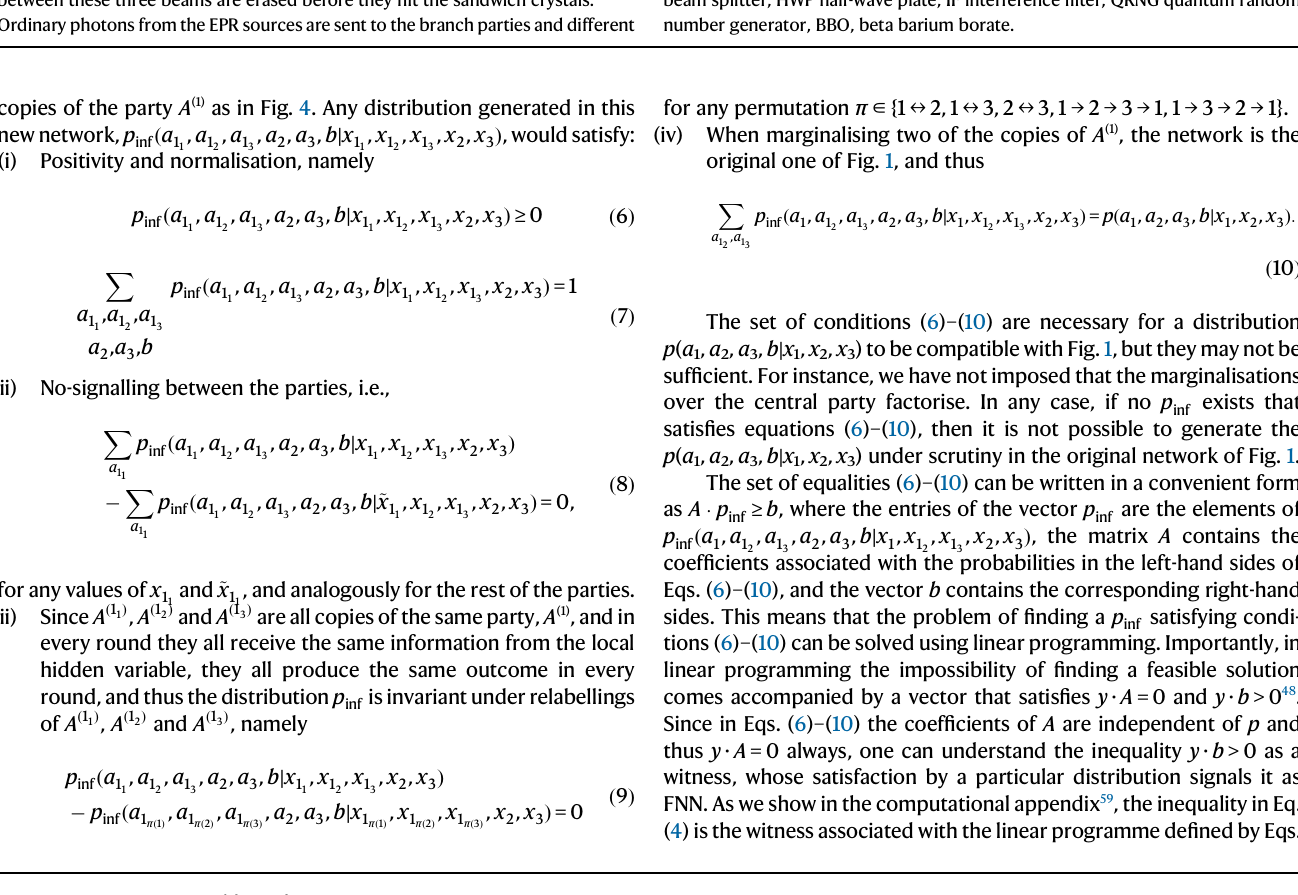
Fig. 5 | Detailed experimental setup. An ultraviolet pulse is generated by a fre- quency doubler and is divided into three parallel beams. The relative phases between these three beams are erased before they hit the sandwich crystals. OrdinaryphotonsfromtheEPRsourcesaresenttothebranchpartiesanddifferent